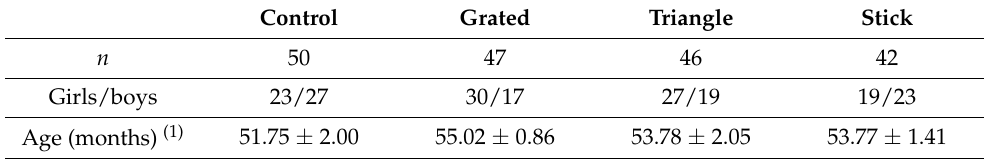
Table 2. Characteristics of the participating children.